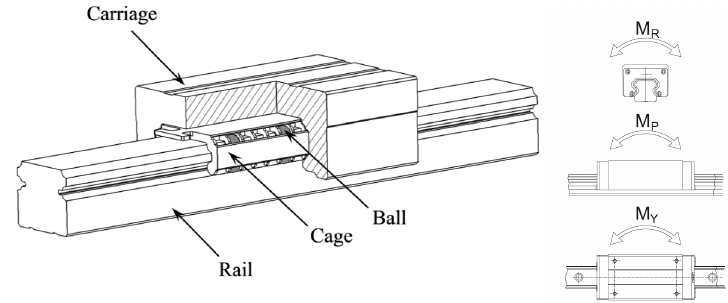
Figure 3. Structure of the slider and its load capacity.